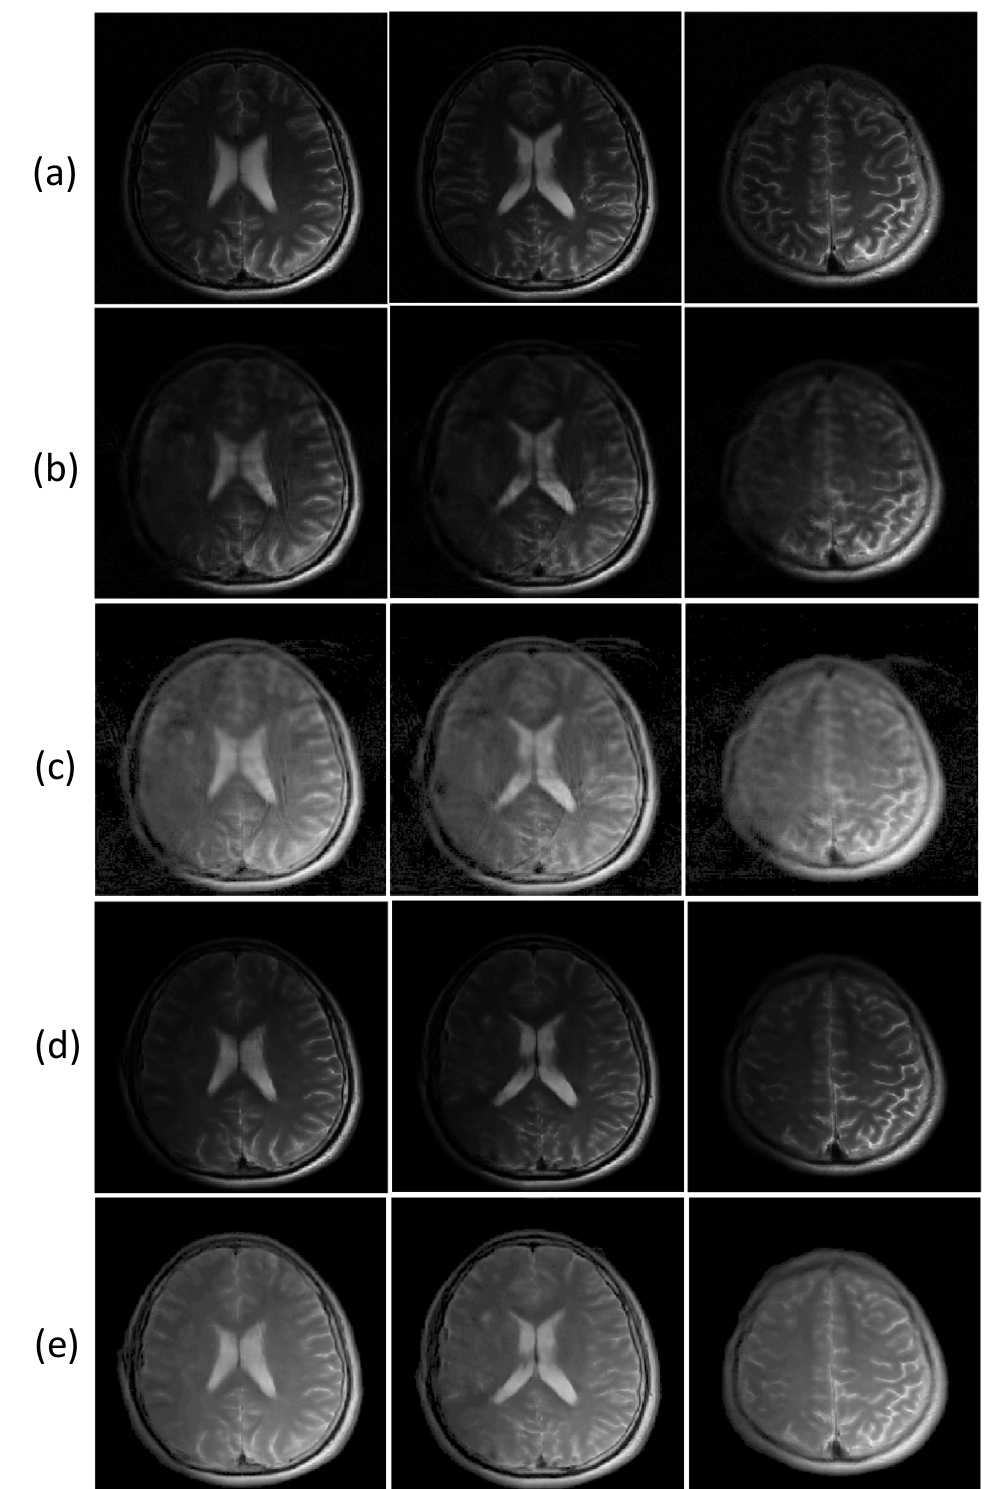
Figure 6. Images reconstructed from a single channel k-space data, which are undersampled with a reduction factor of four: ( a ): label images, ( b , c ): images reconstructed by the DFU and the corre- sponding brightened images, ( d , e ): images reconstructed by the ETER-net and the corresponding brightened images. Brightening was performed by taking the root of each value in the